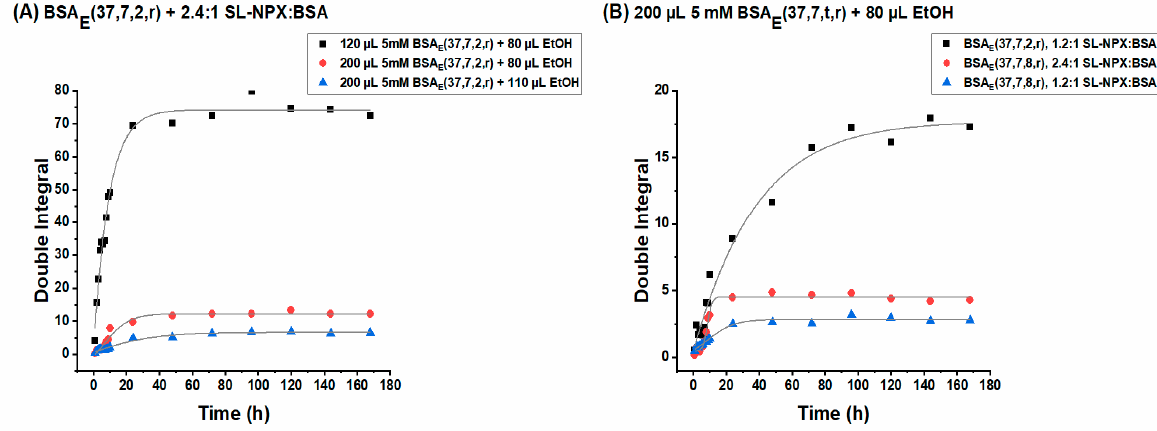
Figure 7. Double integral values as a function of release time intervals for ( A ) SL-NPX-loaded BSA E (37, 7, 2, r) at 2.4:1 SL-NPX:BSA molar ratio prepared by different amounts of BSA and